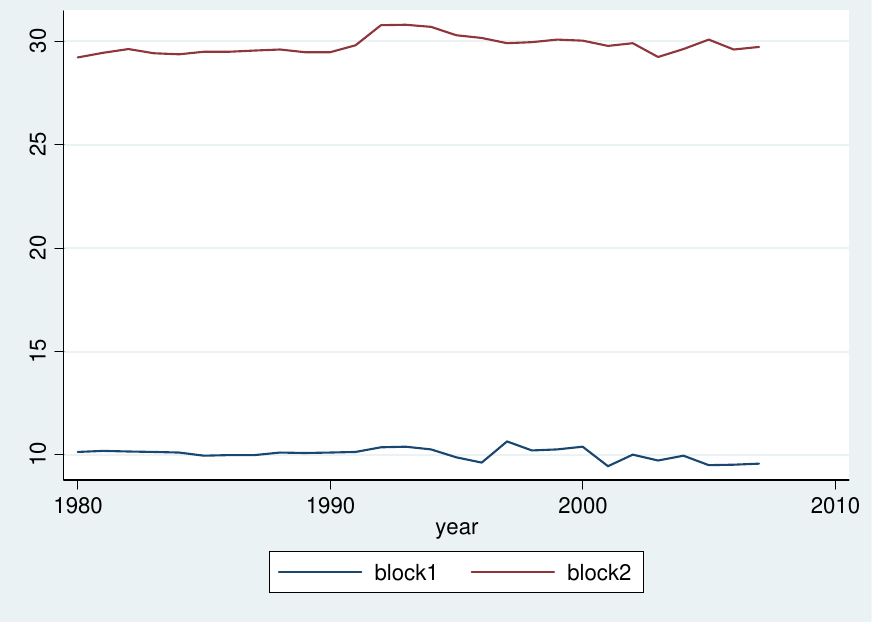
Fig. 1A. Lower consumption block, yearly average values